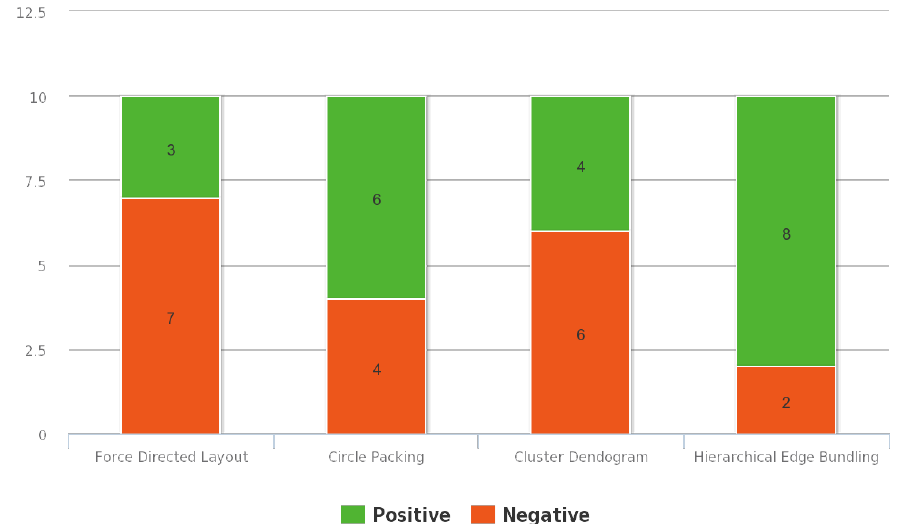
Figure 4. Stacked bar chart representing the distribution of effectiveness for choice of colors